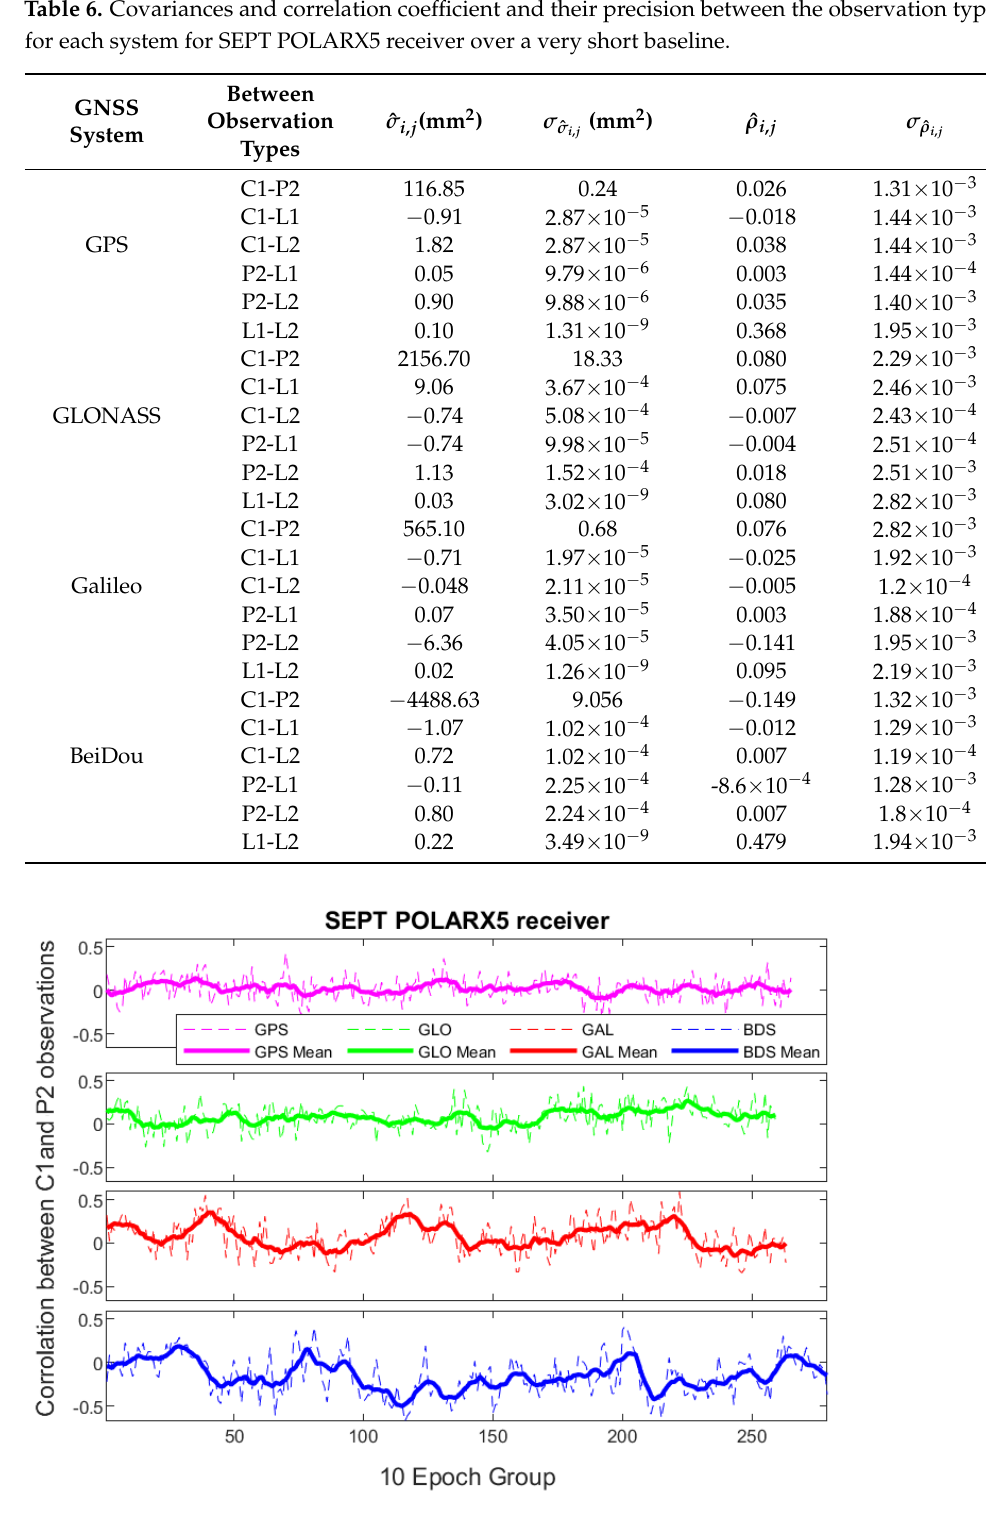
Figure 7. Estimated correlation coefficients between the C1 and P2 observations (dashed line) with their average values in 10 epoch group windows (bold line) over a very short